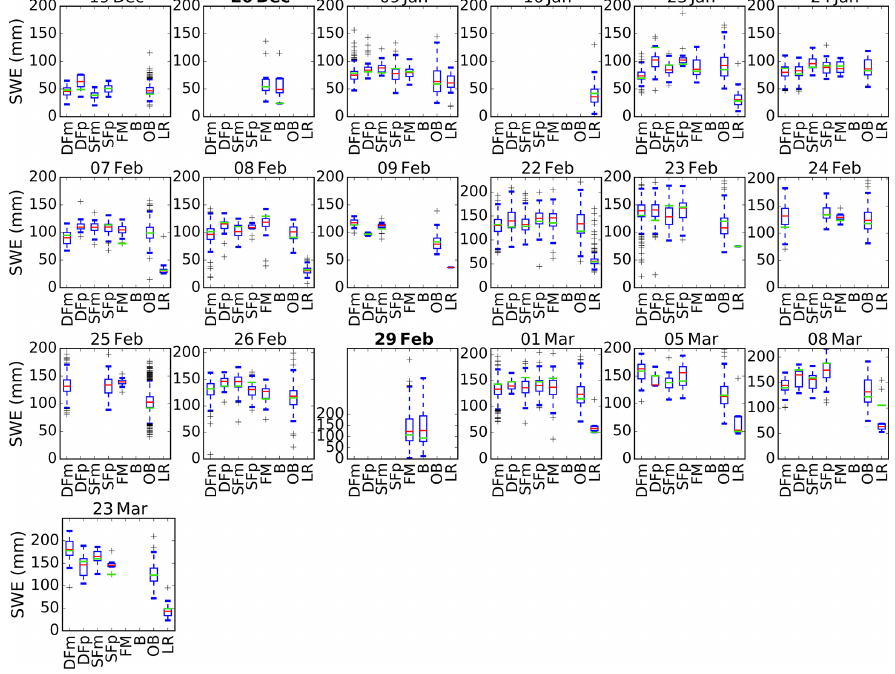
Figure 4. Box plots of measured SWE within each land cover group during the different field measurement days. Measurements from the Saariselkä test site are indicated in